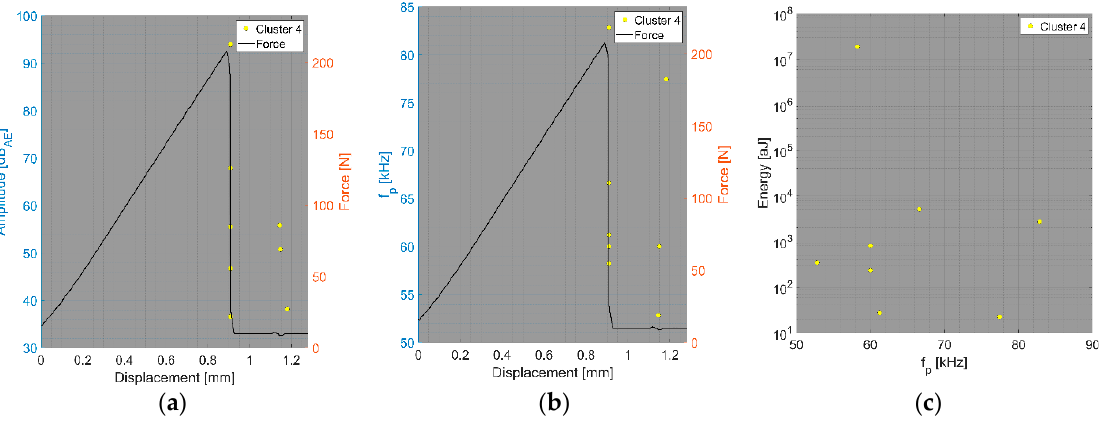
Figure 13. Clustering results for a BRCT representative sample using a spectral clustering algorithm (Fujicera 1045S dataset).